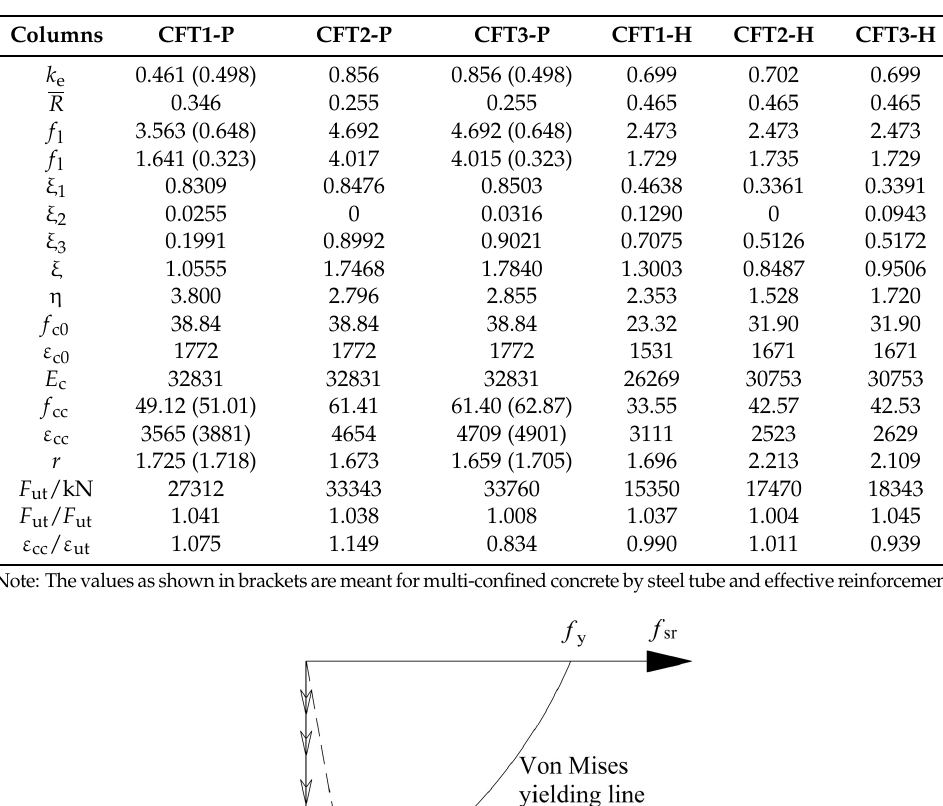
Table 5. Estimated results of related parameters of confined concrete.